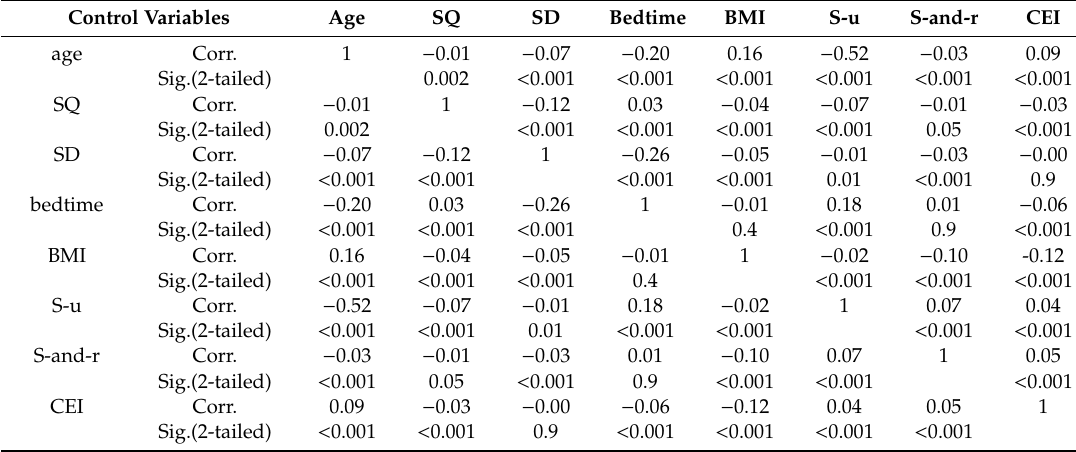
Table 2. Correlation analysis.